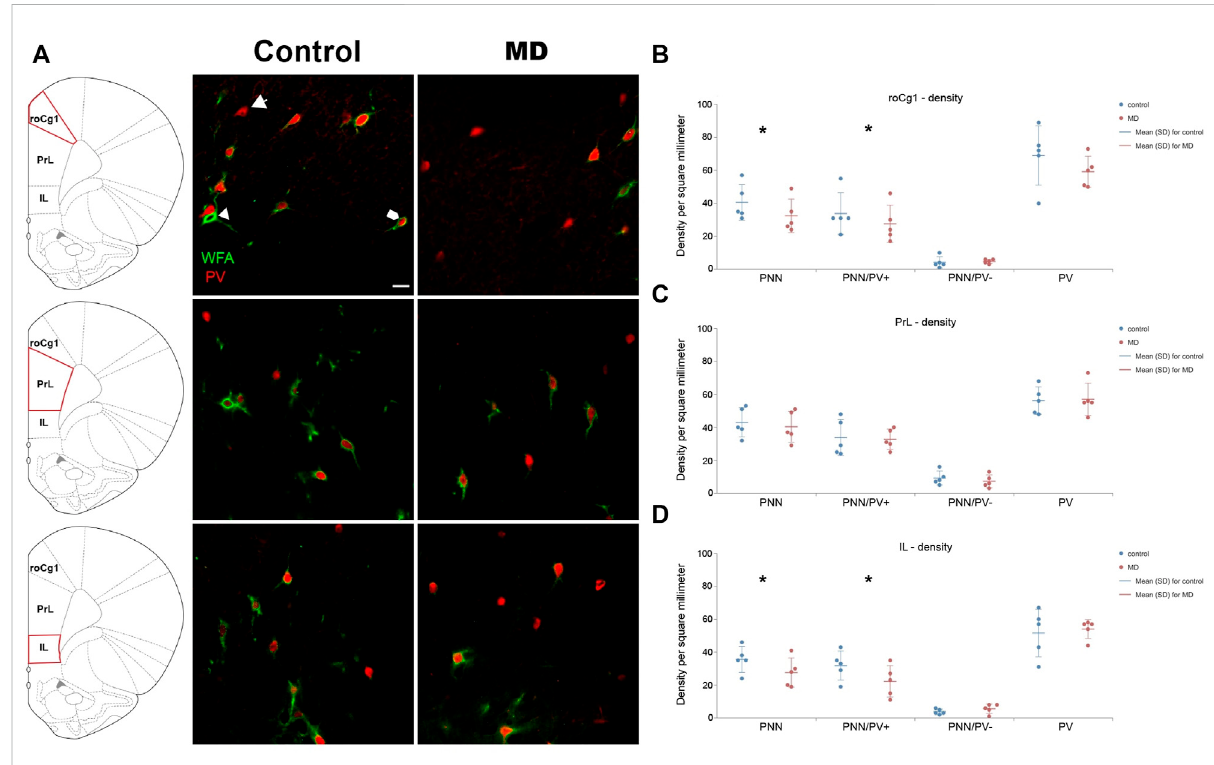
FIGURE 2 Effects of MD on WFA + perineuronal nets and PV + cell density in the mPFC on PND60. (A) Photomicrographs of double WFA/PV immuno fl uorescence showing PNNs surrounding PV + cells (pentagonal arrow), PNNs surrounding PV- cells (arrowhead) and PV + cells lacking PNNs (arrow) in the roCg1, PrL and IL. Dot plot graphs in (B – D) representing quanti fi cations of results as means ± SD (horizontal bars) and observed values (dots) in the roCg1, PrL and IL, respectively. MD reduced density of overall PNNs and PNNs enwrapping PV + cells in the roCg1 (B) and IL (D) . Average number of evaluated PNNs per animal: roCg1 = 54, PrL = 89, IL = 24. *p < 0.001 Control vs. MD. Rostral part of area one of cingulate cortex (roCg1), infralimbic cortex (IL), maternally deprived rats (MD), prelimbic cortex (PrL). Scale bar in A = 25 μ